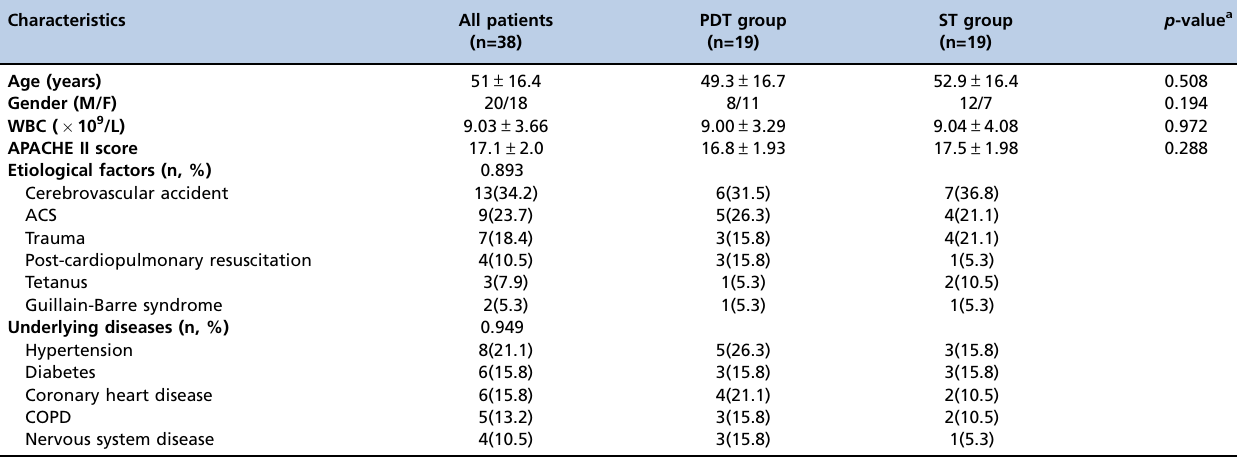
Table 1 - Baseline characteristics of patients without